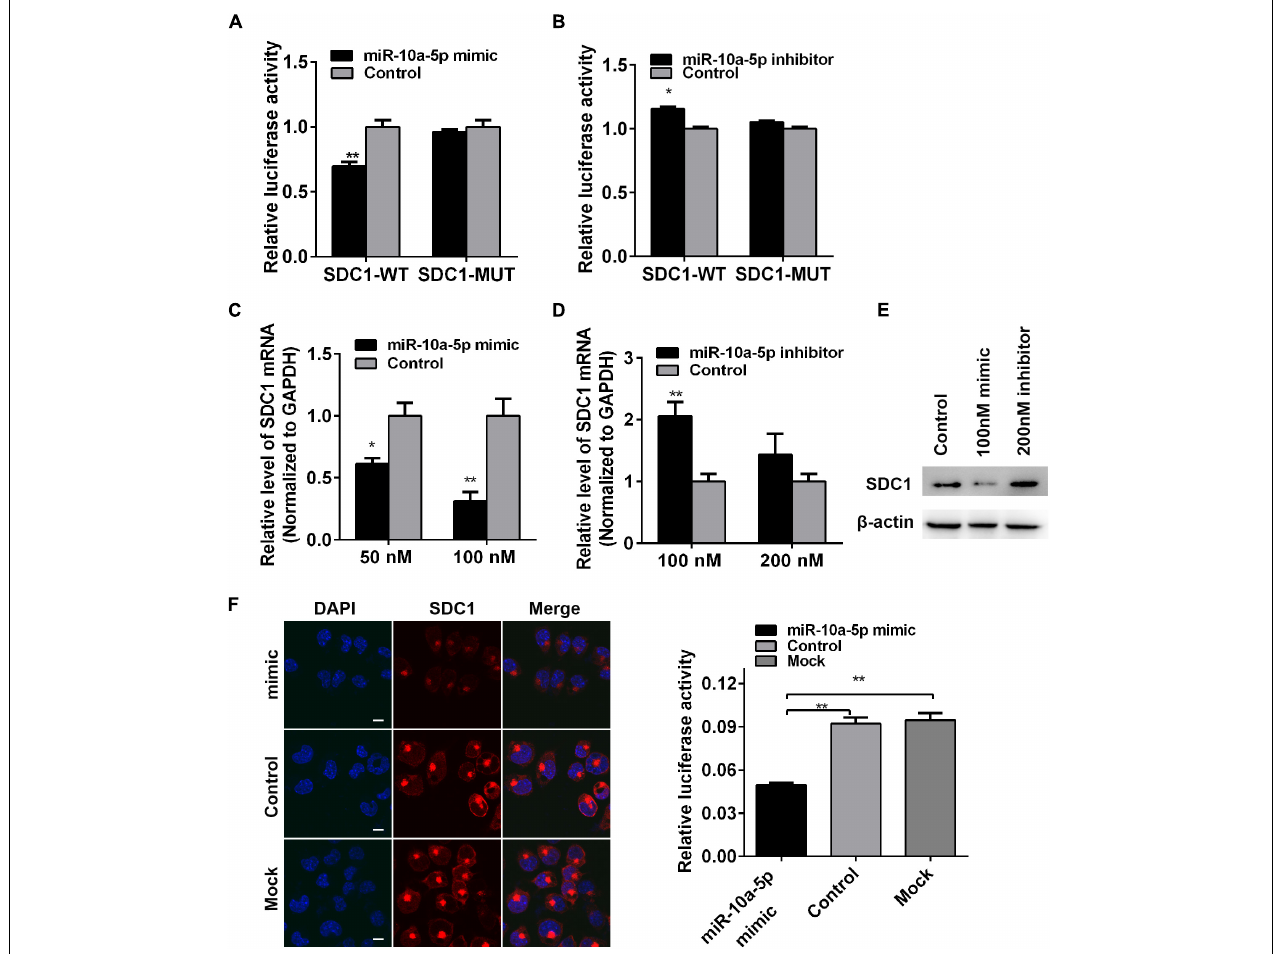
FIGURE 4 | Syndecan 1 (SDC1) mRNA is a target of miR-10a-5p. (A) Wild-type (WT) or mutant-type (MUT) reporter constructs of SDC1 3’-UTR were co-transfected with 100 nM of miR-10a-5p mimic into HEK293T cells. After 24 h, the Renilla and firefly luciferase activities were assayed. (B) SDC1-WT or SDC1-MUT reporter was co-transfected with 200 nM of miR-10a-5p inhibitor into HEK293T cells for 24 h and were then harvested and subjected to luciferase activities detection. (C) N2a cells were transfected with different concentrations of miR-10a-5p mimic for 48 h, and the SDC1 mRNA expression was determined by qRT-PCR. (D) N2a cells pre-transfected with miR-10a-5p inhibitor for 48 h were subjected to SDC1 level determination by qRT-PCR. (E) Cells were pre-treated as indicated in panels (C,D) , lysed, and detected by western blotting assay to examine the level of PHEV protein. Data were normalized to beta actin. All of the data are representative of at least three independent experiments (* p < 0.05, ** p < 0.01). (F) Representative micrograph of IFA showed the expressed level of SDC1 (red) in the miR-10a-5p mimic- or mock-transfected N2a cells. Nucleus was stained with DAPI (blue). Quantitative analyses of the SDC1 staining are listed on the right. Bars, 20 µ